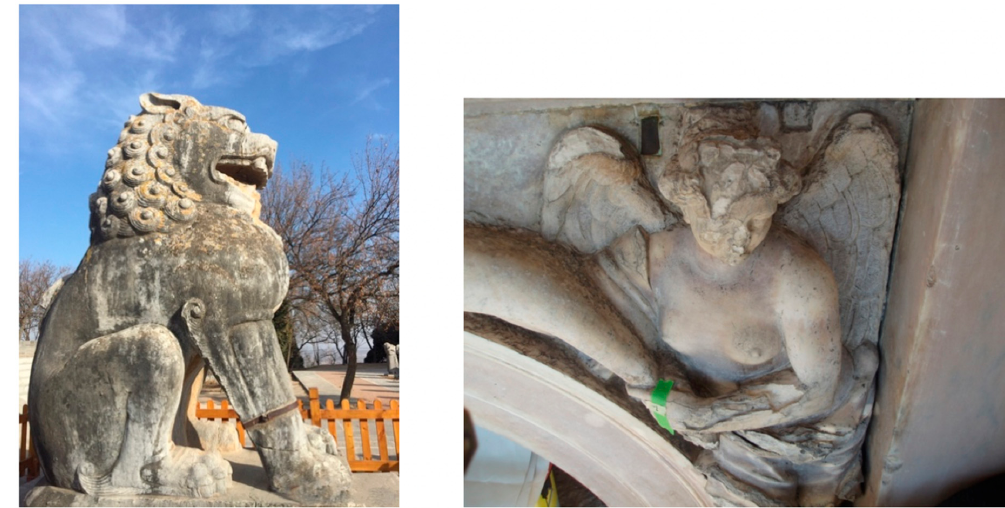
Figure Figure 1. Examples of stone artifacts with typical black crust, biological colonization, and decohesion phenomena.